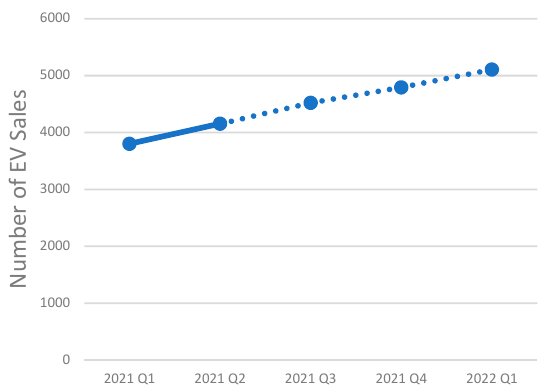
Figure 9. The prediction of electricity demands in County Durham.